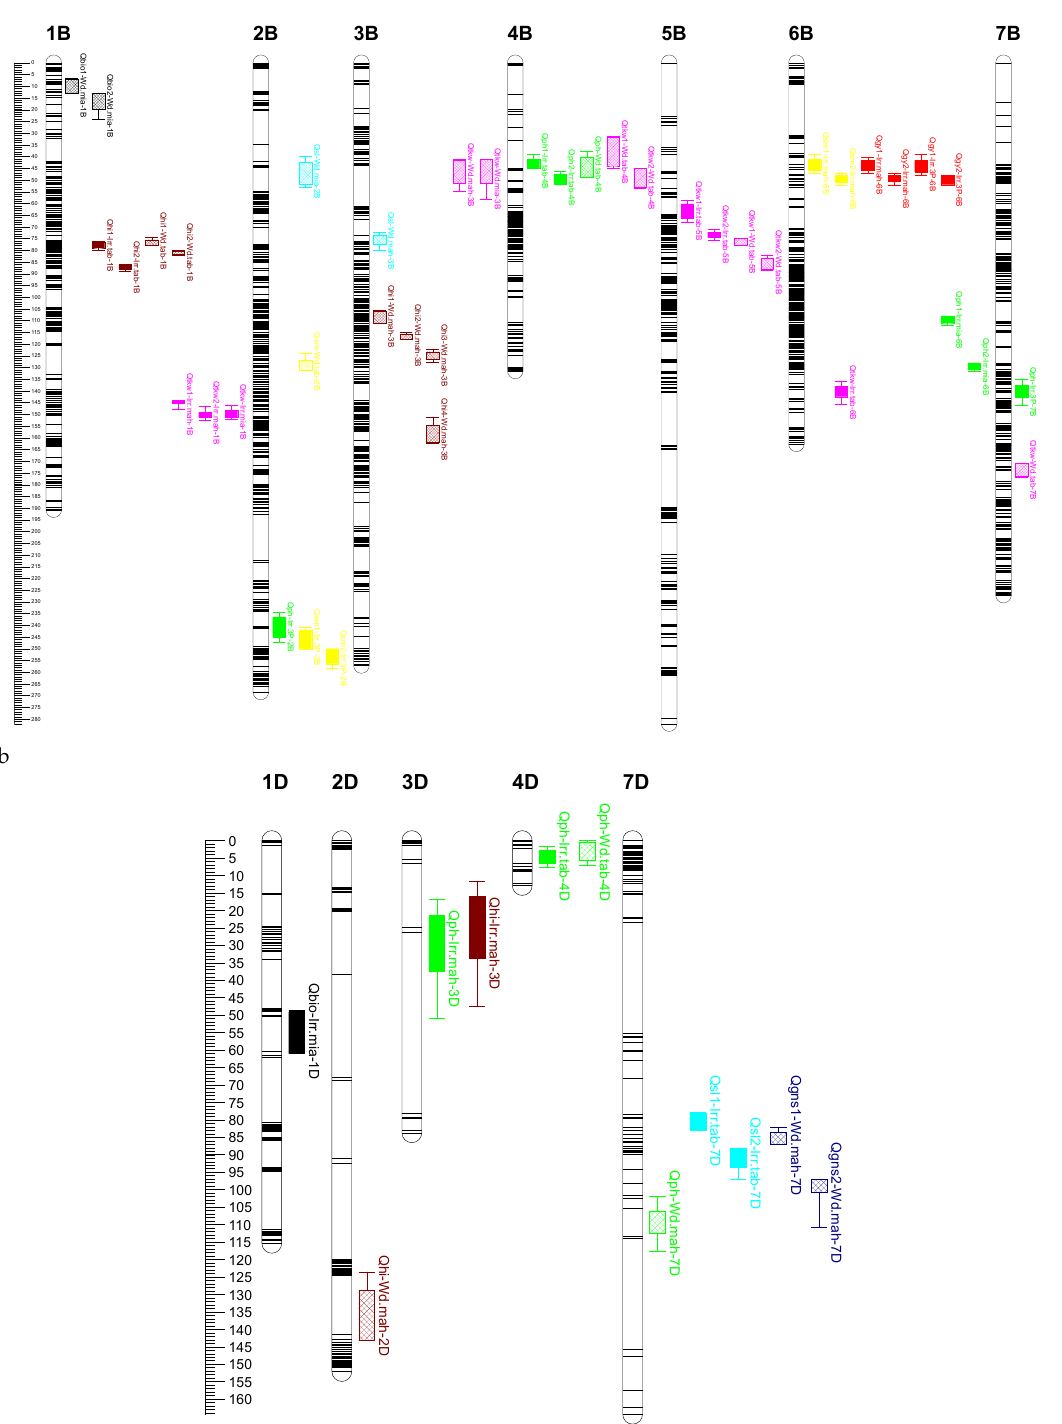
Figure 3. Location of QTLs on the genetic linkage map of wheat developed from the cross #49 × Yecora Rojo under irrigated (solid filled box) and water deficit (stripes filled box) condi- tions in ( a ) A genome, ( b ) B genome and ( c ) D genome. Each chromosome is represented by map positions by cM (on the left) and identified QTLs (on the right). QTL names indicate the trait, trail (water condition + environment) and chromosome name along with different colors: GY (red), PH (green), SM (yellow), TKW (pink), GNS (blue), SL (light blue), BIO (black), HI